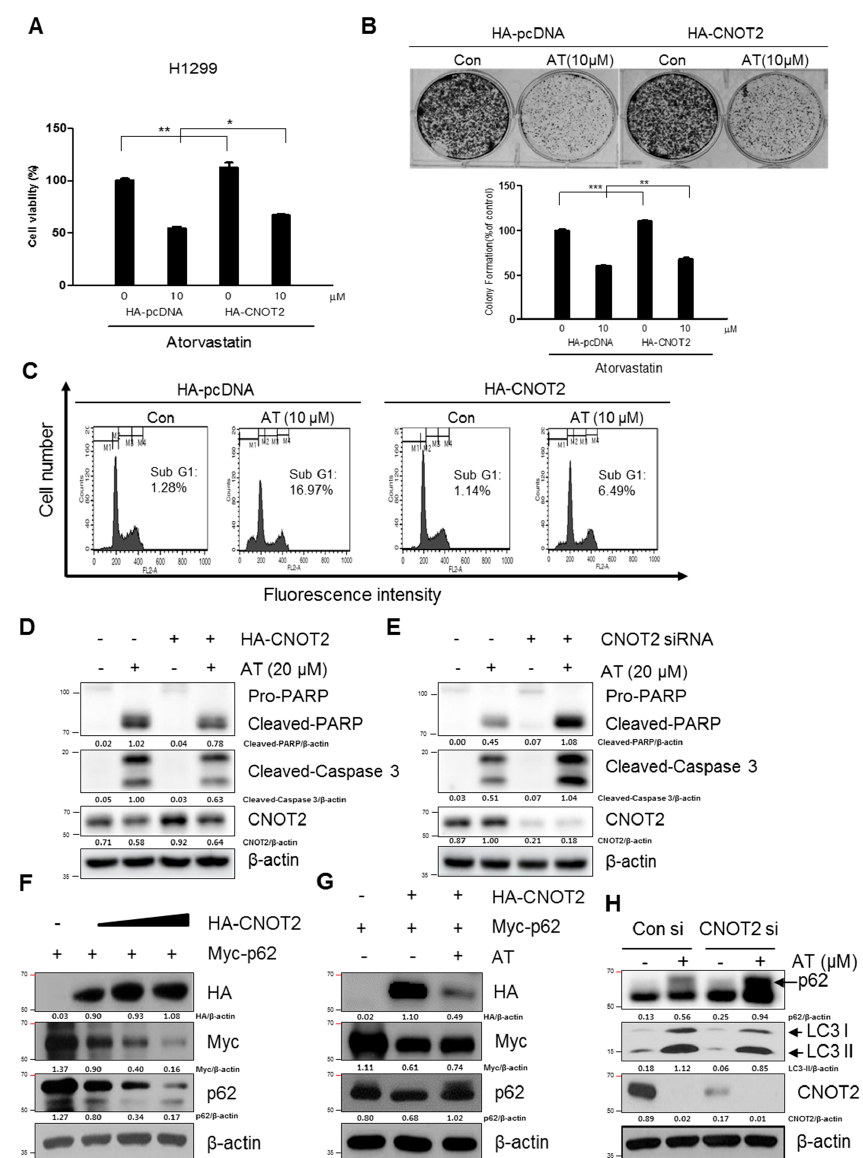
Figure 6. Critical role of CNOT2 in Atorvastatin induced apoptotic and autophagic cell death in H1299 cells. ( A ) E ff ect of CNOT2 overexpression on cytotoxicity in Atorvastatin treated H1299 cells transfected with HA-CNOT2 plasmid. ( B ) E ff ect of CNOT2 overexpression on anti-proliferative e ff ect in Atorvastatin (10 µ M) treated H1299 cells after transfection with HA-CNOT2 plasmid. ( C ) E ff ect of CNOT2 overexpression on Sub-G1 population in Atorvastatin (10 µ M) treated H1299 cells for 48 h after transfection with HA-CNOT2 plasmid. * p < 0.05. ** p < 0.01 vs. untreated control. ( D ) E ff ect of CNOT2 overexpression on cleavages of PARP and caspase3 in Atorvastatin (20 µ M) treated H1299 cells transfected with HA-CNOT2 plasmid. ( E ) E ff ect of CNOT2 depletion on cleavages of PARP and caspase3 in Atorvastatin (20 µ M) treated H1299 cells by siRNA transfected with control or CNOT2 siRNAs. ( F ) E ff ect of CNOT2 overexpression on p62 expression in H1299 cells transfected with HA-CNOT2 plasmid. Western blotting was conducted with antibodies of Myc-p62, p62 and HA-CNOT2 in H1299 cells with or without treatment of Atorvastatin (10 µ M). ( G ) E ff ect of CNOT2 overexpression on p62 accumulation by Atorvastatin in H1299 cells transfected with HA-CNOT2 plasmid. ( H ) E ff ect